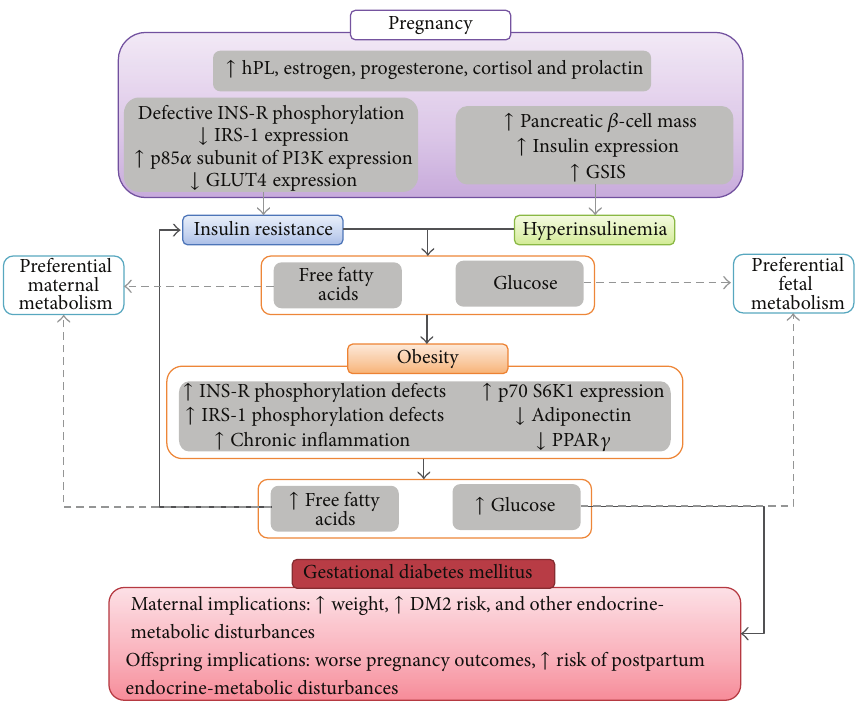
Figure 2: Mechanisms underlying insulin resistance in normal pregnancy physiology and gestational diabetes mellitus. Insulin resistance is a physiologic state which develops parallel to increased secretion of hPL, estrogen, progesterone, cortisol, and prolactin, principally. Although they favor IR by altering components of peripheral insulin signaling cascades, they also activate various mechanisms enhancing 𝛽 -cell function. The result is an increased release of free fatty acids, which are predominantly metabolized by mothers, allowing for shunting of glucose towards fetal metabolism. In obesity several pathophysiologic mechanisms worsen IR in target tissues, leading to greater free fatty acid levels and dysregulation of glucose homeostasis. DM2: type 2 diabetes mellitus; GSIS: glucose-stimulated insulin secretion; hPL: human placental lactogen; INS-R: insulin receptor; IRS-1: insulin receptor substrate-1; PPAR 𝛾 : peroxisome proliferator-activated receptor 𝛾